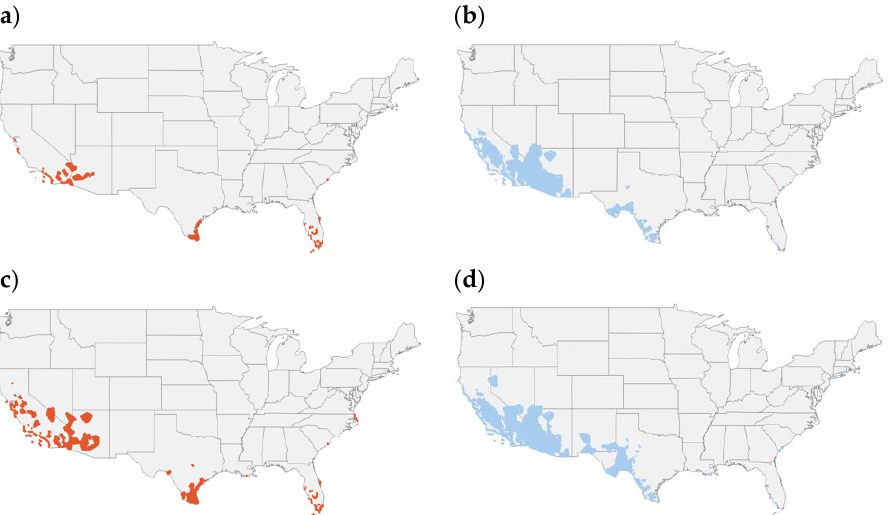
Figure 6. Combination of precipitation (25 mm threshold) and temperature (at 32 ◦ F and 28 ◦ F) for November and December (all 10th percentile) note: 32 ◦ F = 0 ◦ C, 28 ◦ F = − 2.2 ◦ C). ( a ) 25 mm rainfall and 32 ◦ F in December ( b ) 25 mm rainfall 32 ◦ F in November ( c ) 25 mm rainfall and 28 ◦ F in December ( d ) 25 mm rainfall and 28 ◦ F in November.